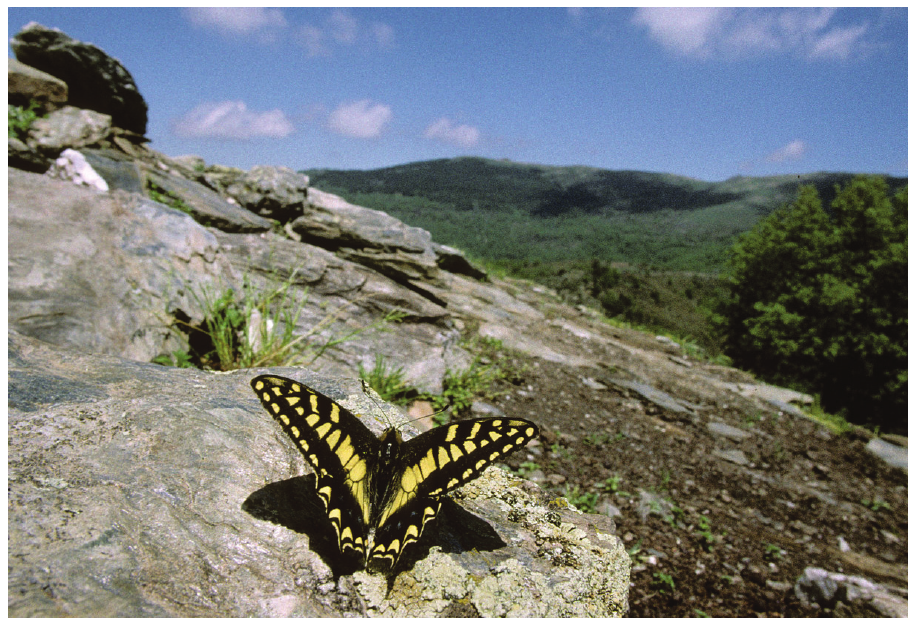
Papilio hospiton in its habitat. Photo: Tom Nygaard